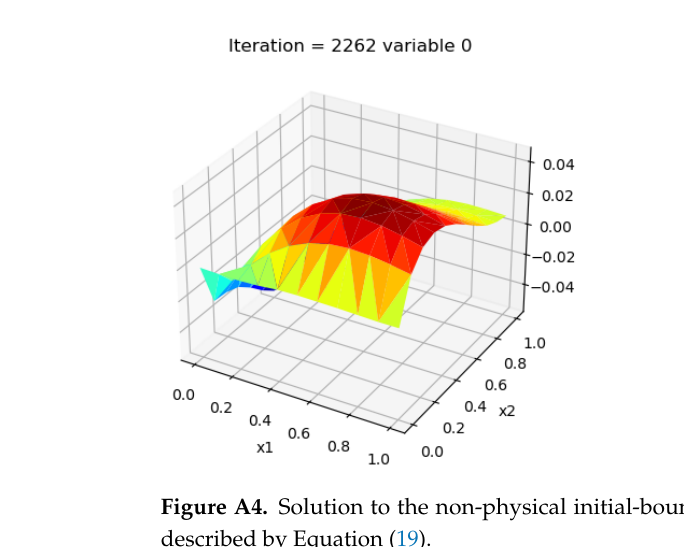
Figure A4. Solution to the non-physical initial-boundary value problem of the KdV equation, as described by Equation (19).